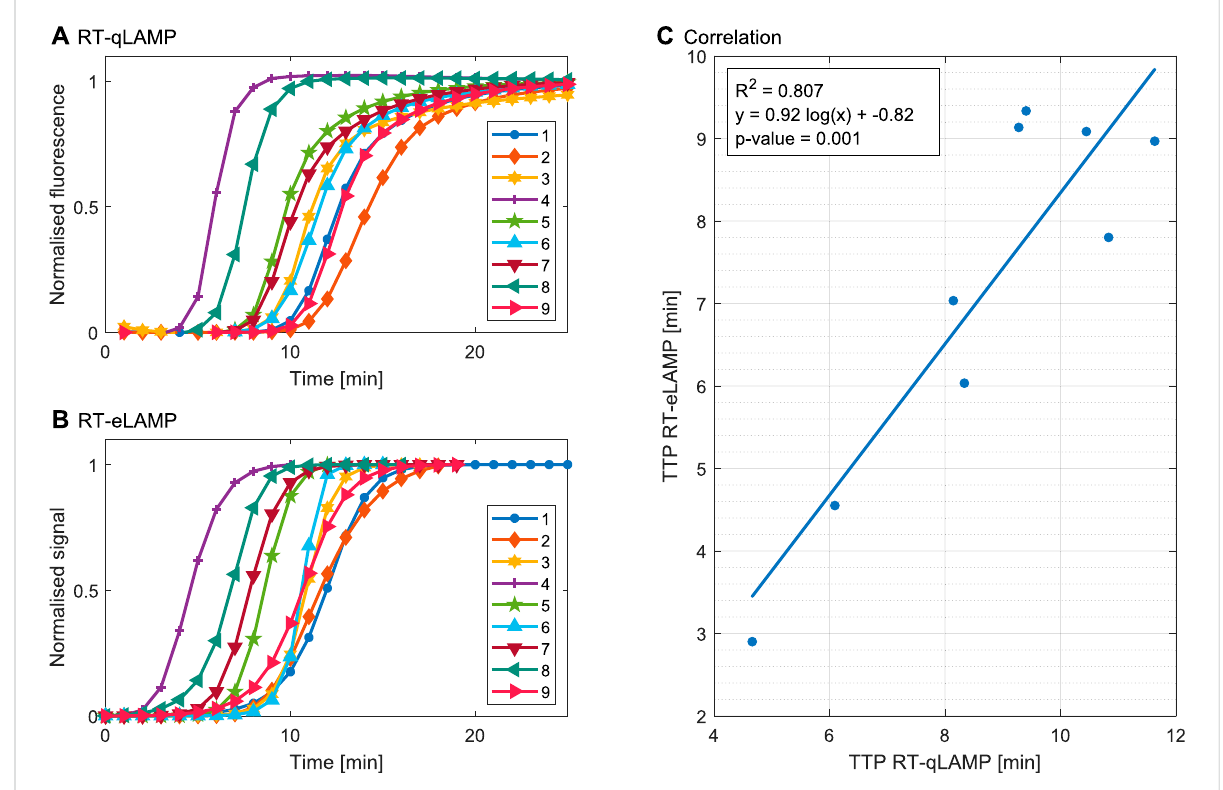
FIGURE 5 Validation of the RT-LAMP assay for DENV-2 clinical samples in the gold-standard qPCR instrument and the LoC Lacewing platform based on onerepeat. (A) Ampli fi cationcurvesindicatingnormalised fl uorescencefortheRT-qLAMPassay. (B) Compensated,linearisedandnormalisedsensor output curves corresponding to ampli fi cation curves for the RT-eLAMP assay. (C) Correlation between the TTP calculated from C t RT-qLAMP and RT-eLAMP assays. The results demonstrate good correlation for quanti fi cation of the